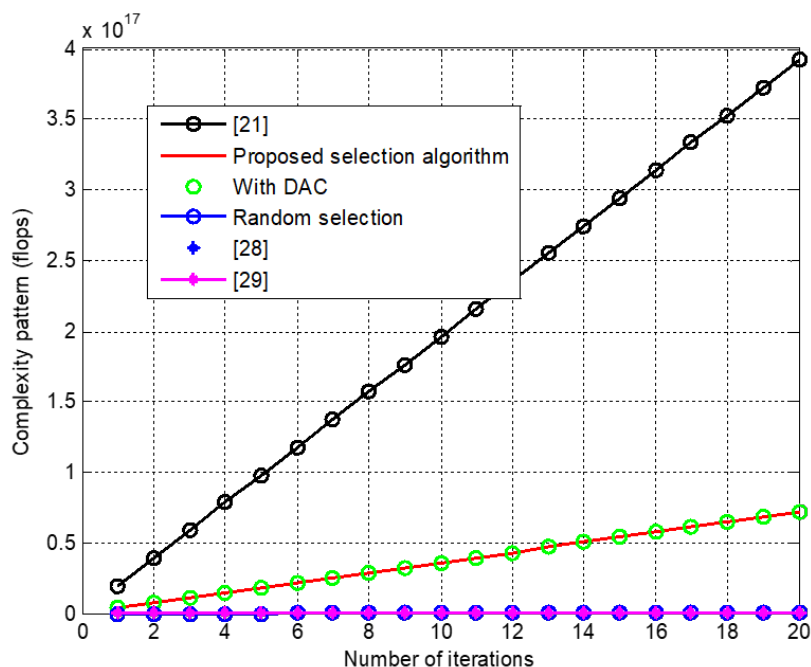
Figure 12. Computationalx complexity of selection algorithms with adaptive (cid:96) (cid:63) and M =